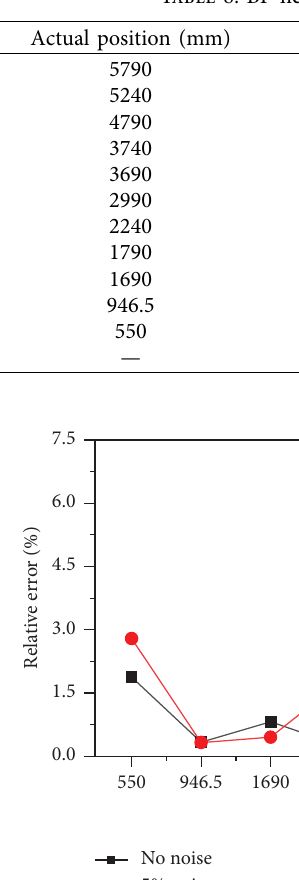
Table 8: BP neural network location results with (%)